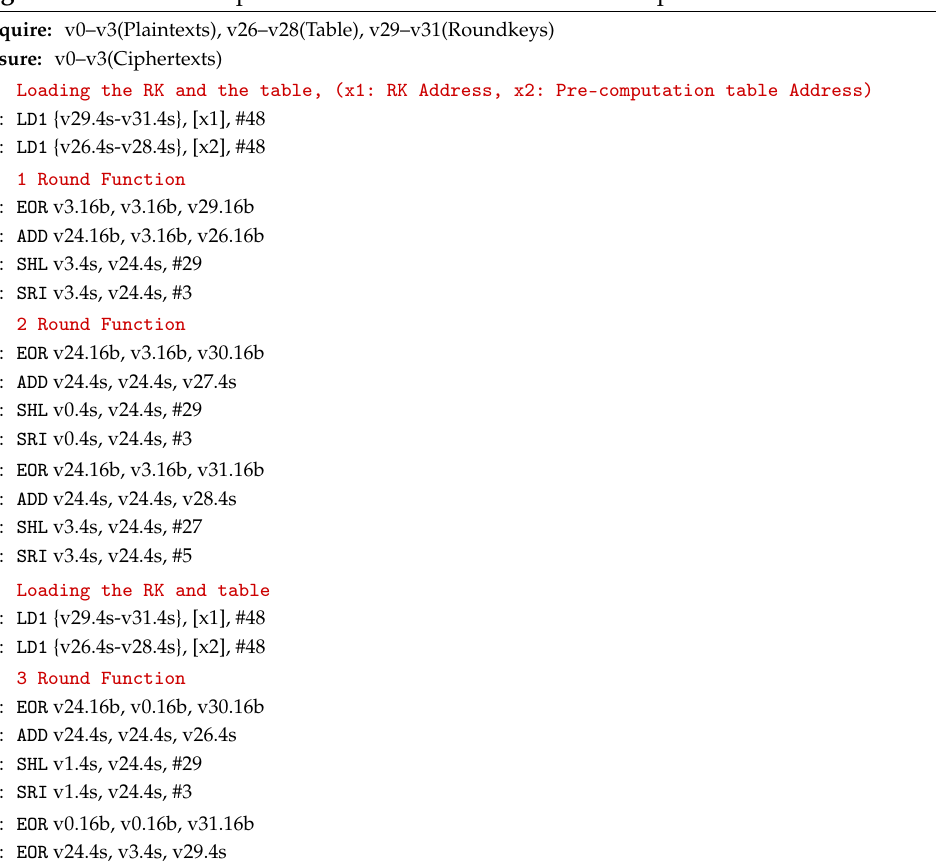
Algorithm 5 Parallel implementation of LEA-128 CTR mode